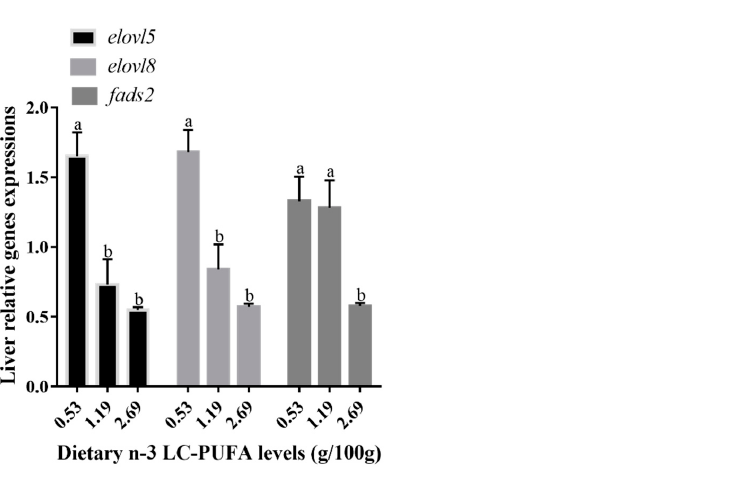
Figure 7. Relative mRNA expression of elovl5 , elovl8 and fads2 in liver of hybrid grouper fed diets with different levels of n-3 LC-PUFA. Results are expressed as means standard error (n = 3). Different letters above the bars denote significant ( p < 0.05) differences among dietary groups.